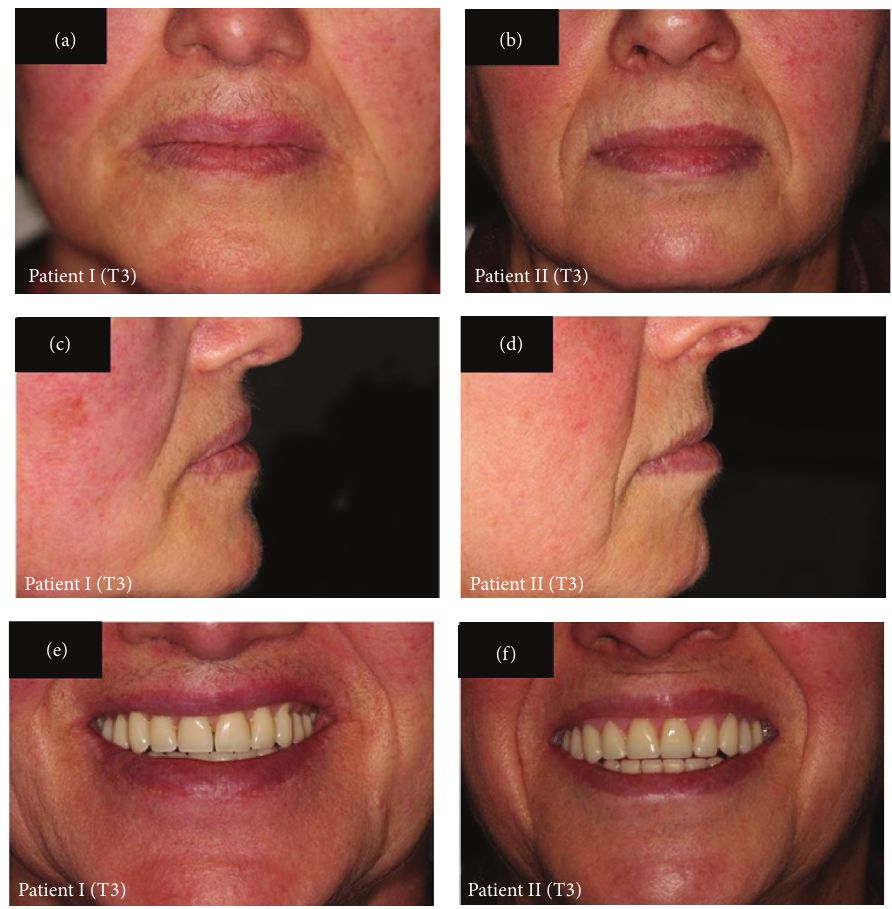
Figure 3: Images of clinical conditions of patients I and II after 4 years of rehabilitation or T3. (a) Resting posture of patient I. (b) Resting posture of patient II. (c) Facial profile of patient I. (d) Facial profile of patient II. (e) Smile of patient I. (f) Smile of patient